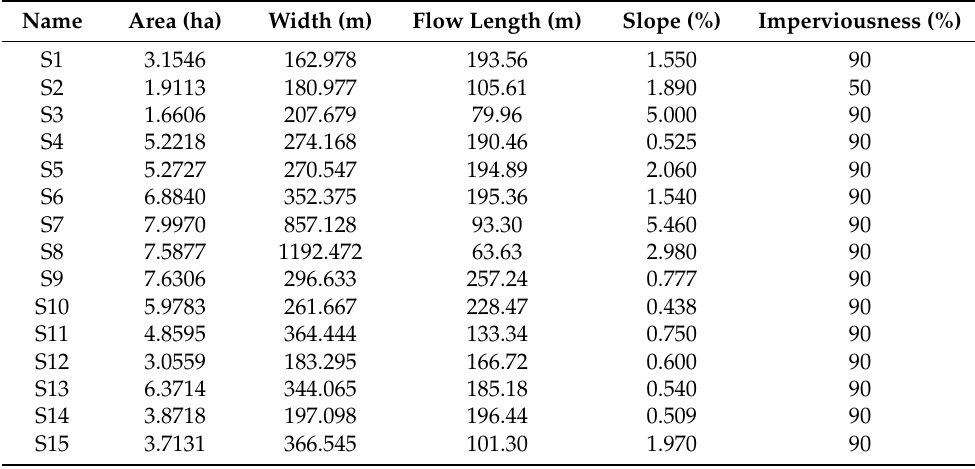
Table A2. Hydrology input parameters for the 1-D–2-D drainage overflow